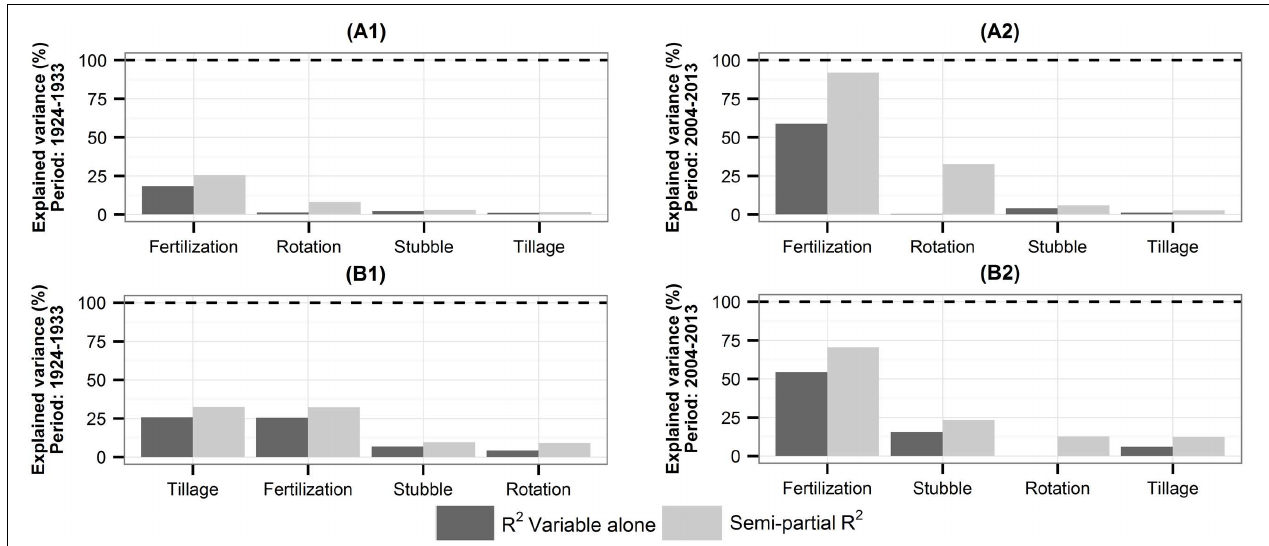
FIGURE 5 | Contribution of the management practices to SOC variations for Brigalow (A) and Wubin (B) soils and climates. (A1,B1) First 10 years of the simulations and (A2,B2) last 10 years of the simulations. R 2 of the variable i and the semi-partial R 2 represent the contribution of the variable alone and the contribution of the variable with its interaction with other variables to the SOC variance, respectively.